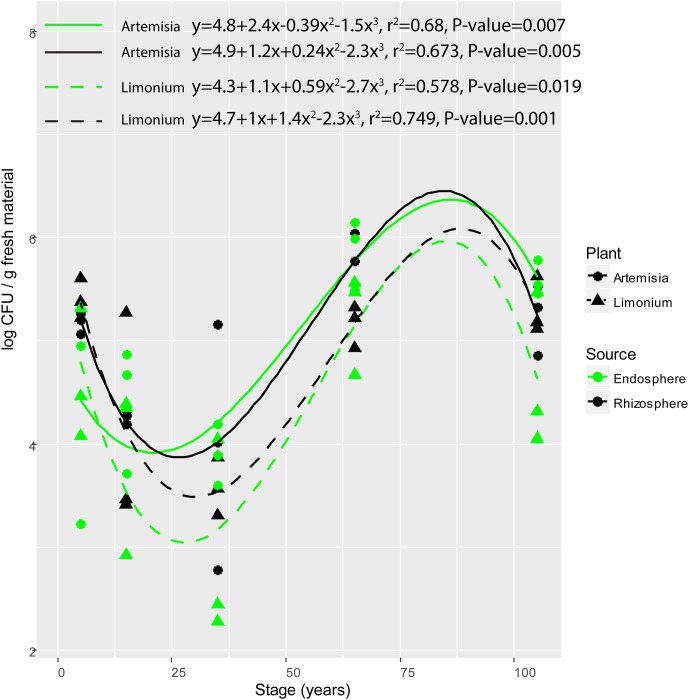
Variation of colony forming units (CFU) of root-associated bacterial isolates along the chronosequence. For plant species, solid and dashed line represent A. maritima and L. vulgare, respectively. For plant compartments, black refer to rhizosphere isolates whereas green represent those obtained from the endosphere.